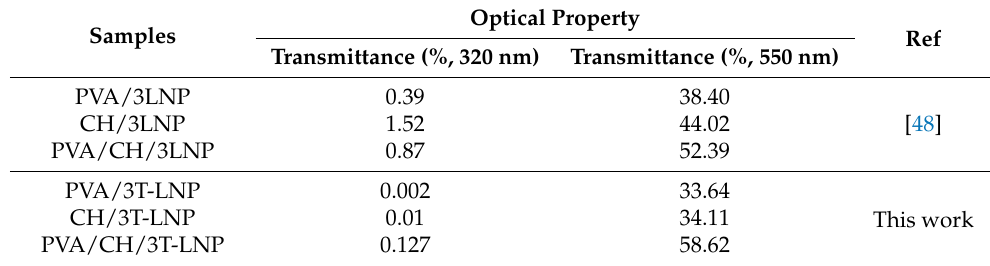
Table 4. Optical property comparison of prepared PVA, CH composite films with historical